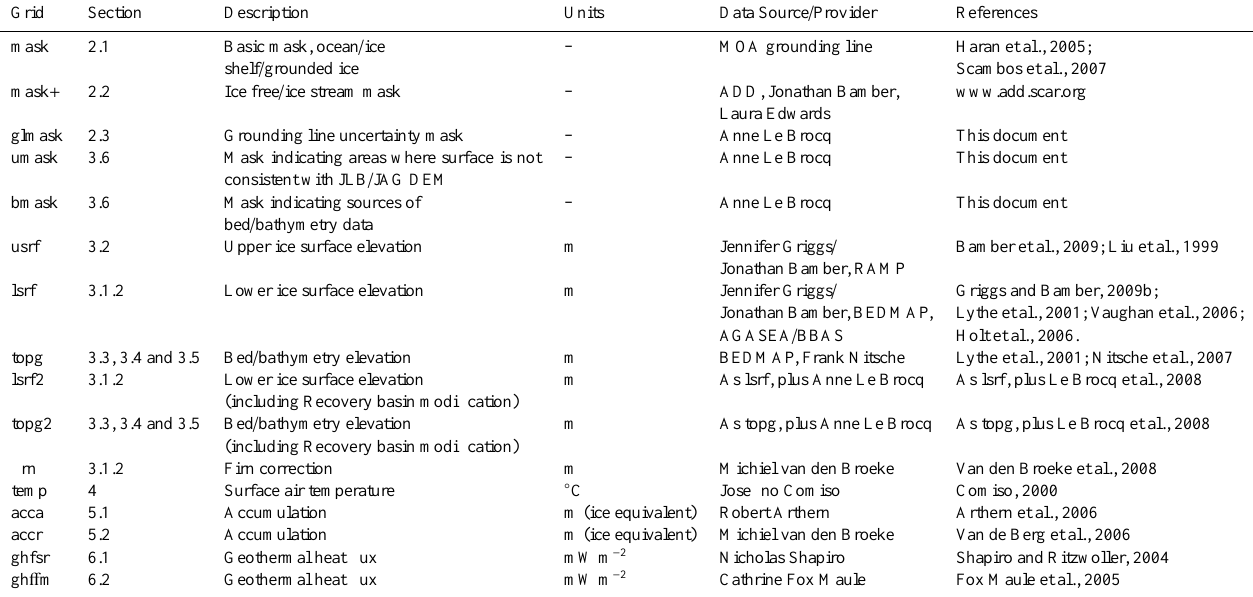
Table 1. List of datasets included and